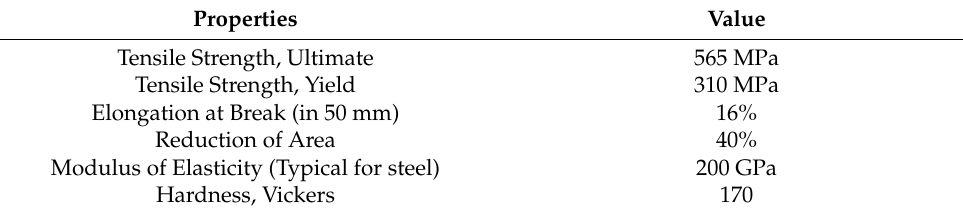
Table 3. Mechanical Properties of AISI